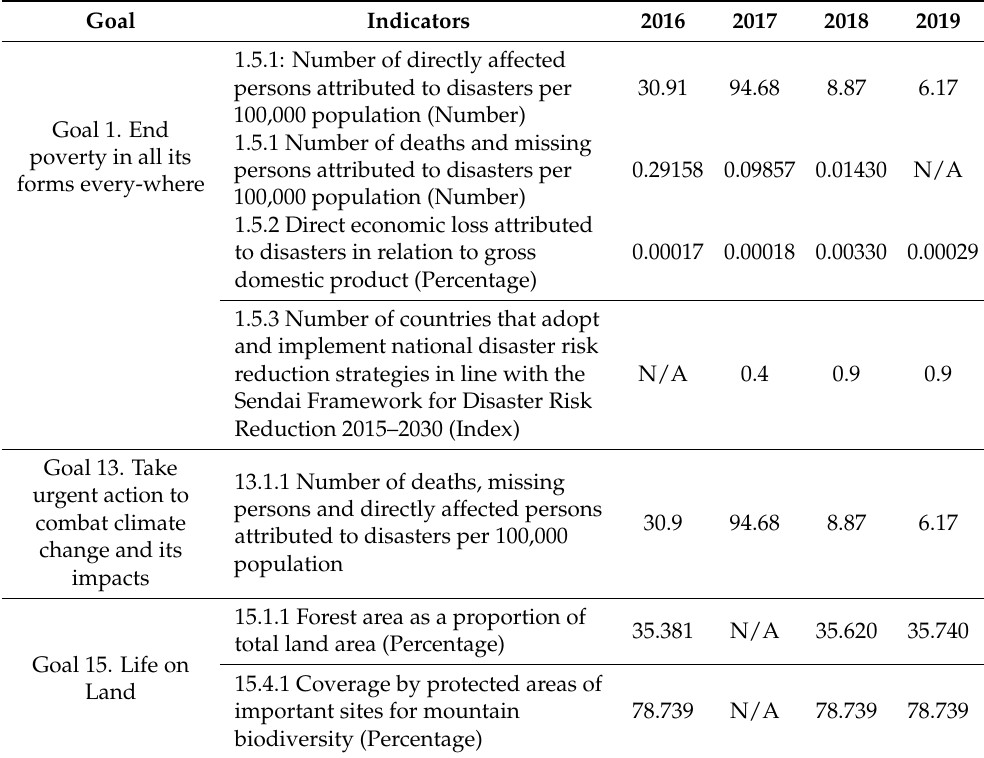
Table A1. SDG values for selected indicators for